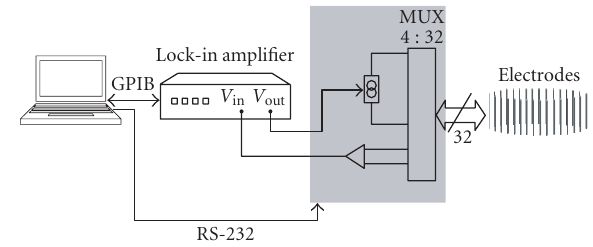
Figure 4: Implemented traditional EIT system for